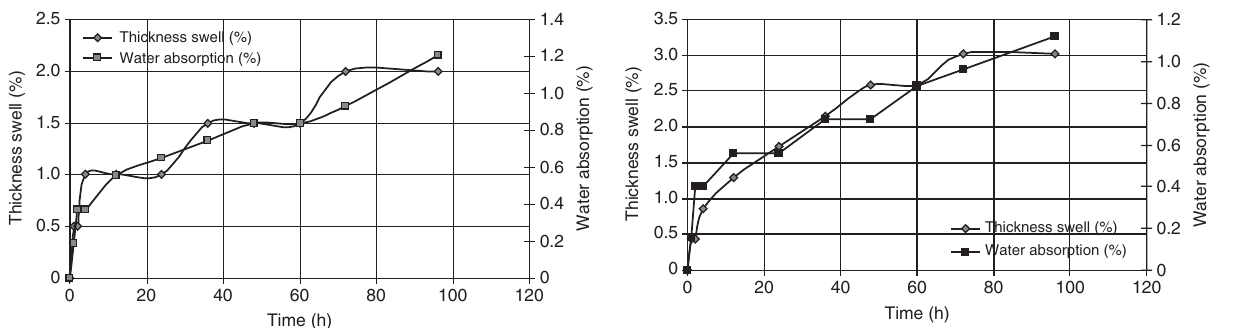
Figure 16 WA and TS for 2 wt% coconut fiber mixed with 20 wt% almond shell-based biocomposite in